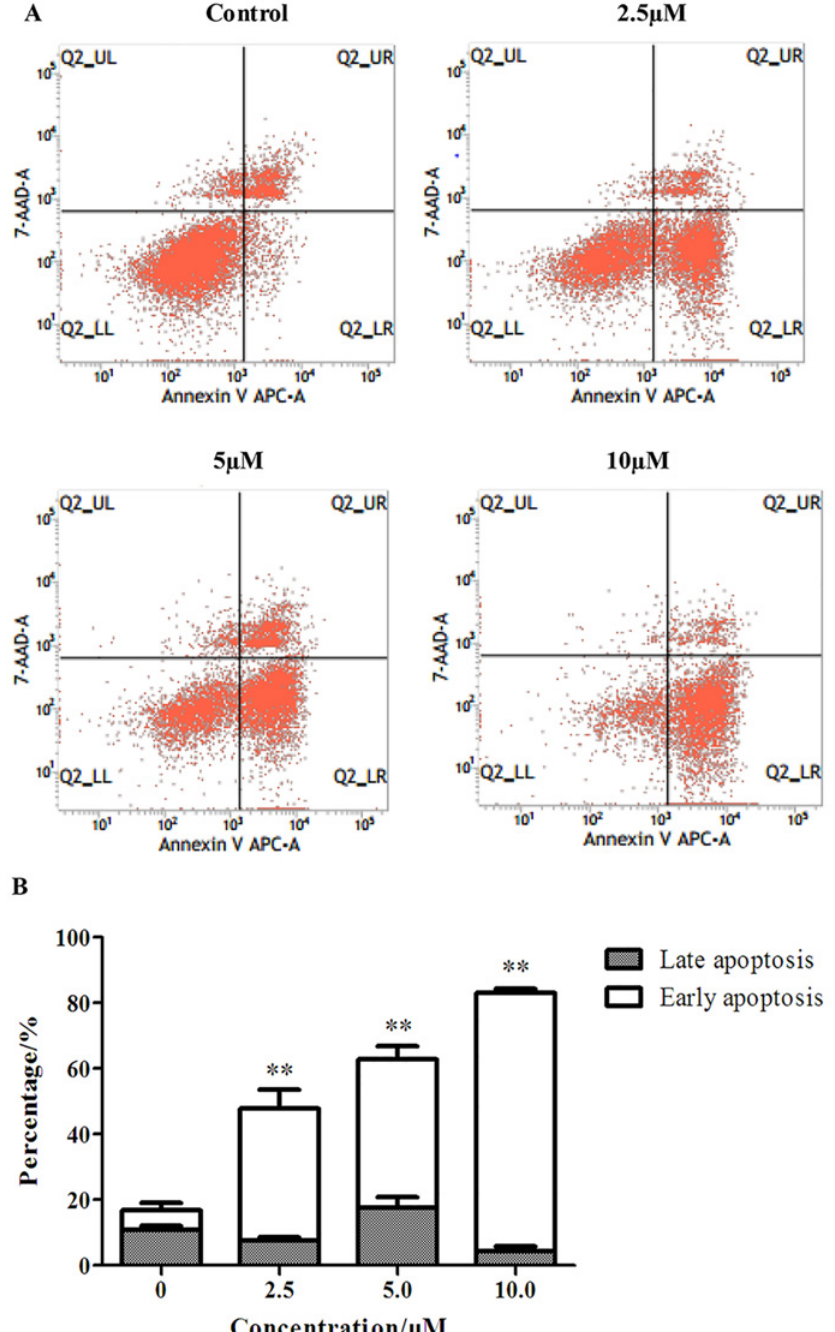
Fig 7. Flow cytometry analysis of apoptosis of HepG2 cells treated with EM-d-Rha. HepG2 cells were incubated for 72h with EM-d-Rha at 0, 2.5 μ M, 5 μ M, 10 μ M, respectively. And cells were stained with FITC conjugated Annexin V and 7-AAD. A: Representative dot plots of Annexin V-FITC/7-AAD staining. a: control, 72h; b: 2.5 μ M EM-d-Rha, 72h; c: 5 μ M EM-d-Rha, 72h; d: 10 μ M EM-d-Rha, 72h. In the scatter plot of double variable flow cytometry, the lower left quadrant Q2-LL shows the living cells (double negative, Annexin V-APC - /7-AAD - ) population. The lower right quadrant Q2-LR represents the early apoptotic (Annexin V-APC + /7-AAD - ) population and upper right quadrant Q2-UR stands for the late apoptotic/necrotic (Annexin V-APC + /7-AAD + ) population; B: Data pooled from three independent experiments show the percentage of apoptotic cells. Difference was considered statistically significant when * p < 0.05 and ** p < 0.01 vs control